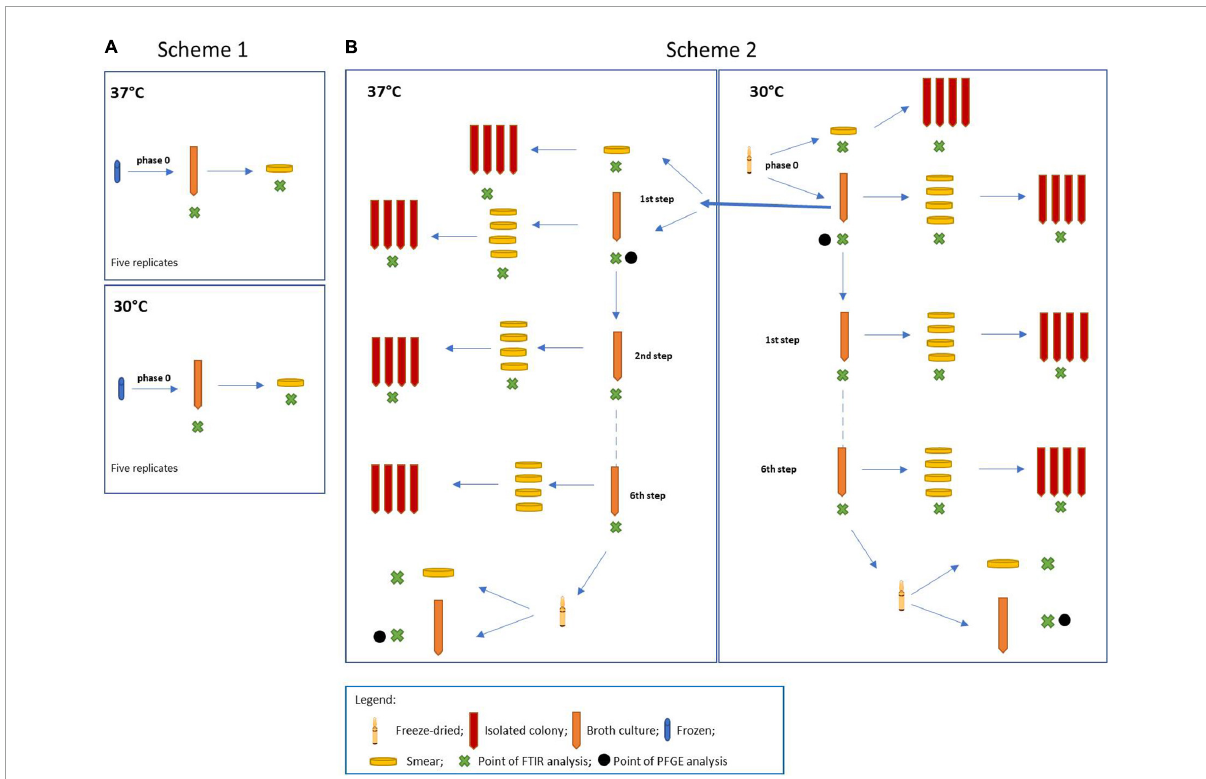
FIGURE1 (A) Scheme 1: experimental scheme for the control strains Lactiplantibacillus plantarum LP01, LP02, and LP09; (B) scheme 2: experimental scheme for the type strain L. plantarum DSM 20174 (LP–CT).